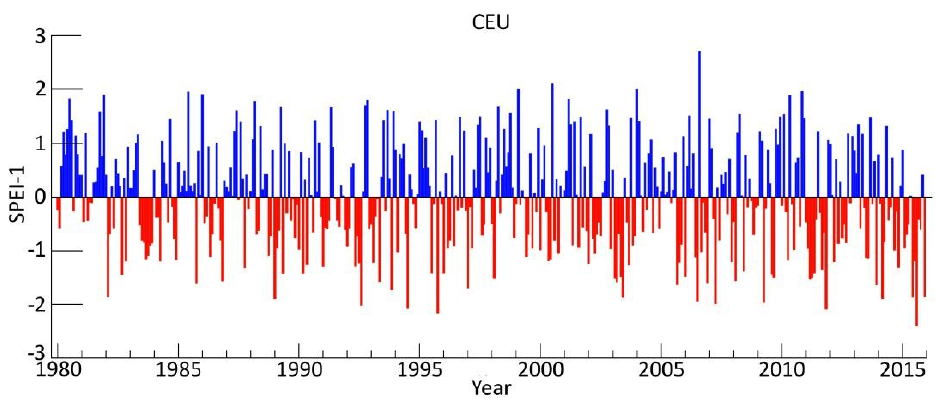
Figure 3. Time series of one-month Standardized Precipitation Evapotranspiration Index (SPEI-1) for the CEU region during 1980–2015. Blue and red bars represent positive and negative values, respectively.